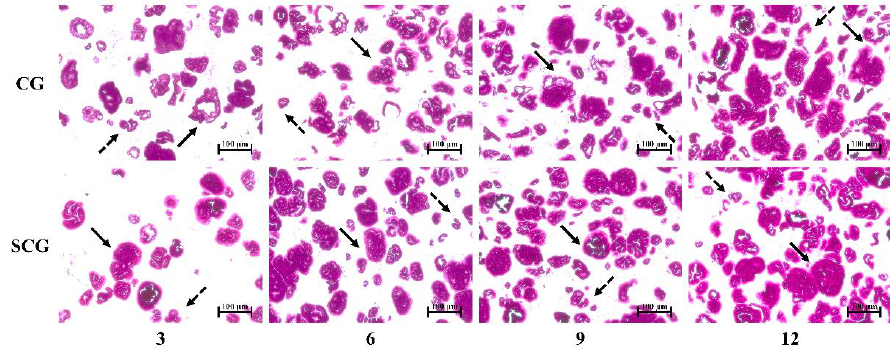
Figure 3. Light microscopy of cooking gels and setting-cooking gels at four starch contents (3%, 6%, 9%, and 12%). indicates large granule starch; indicates small granule starch. Caption: see Figure 1.